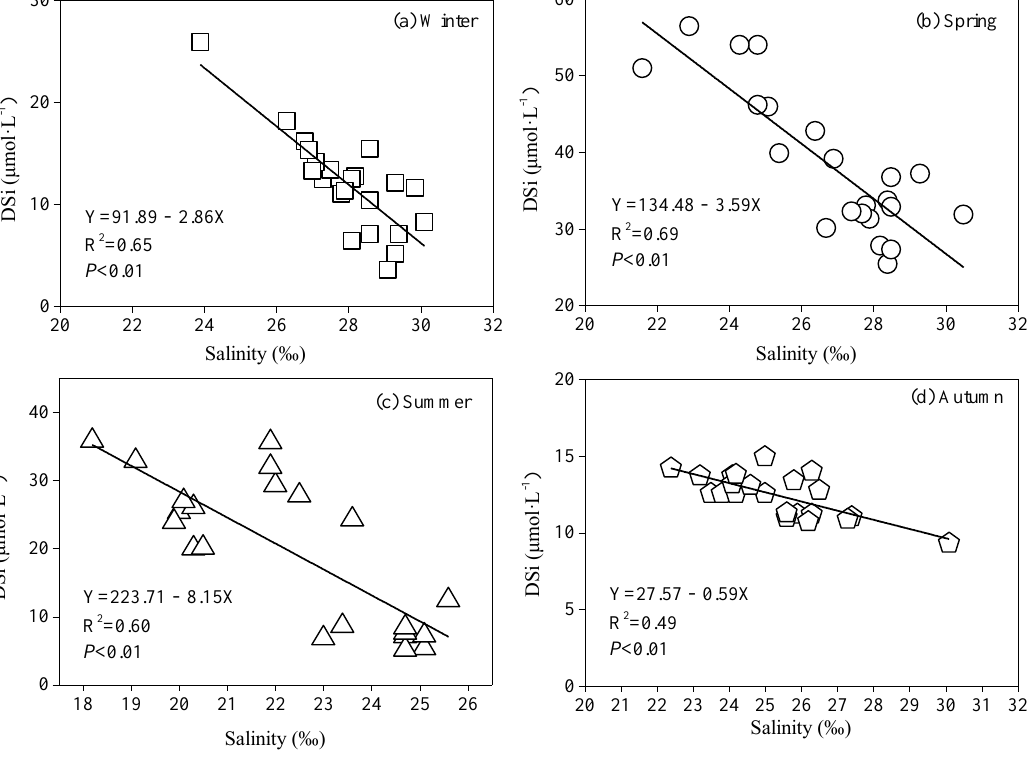
Figure 6. Seasonal variation of DSi behaviors in Zhanjiang Bay.